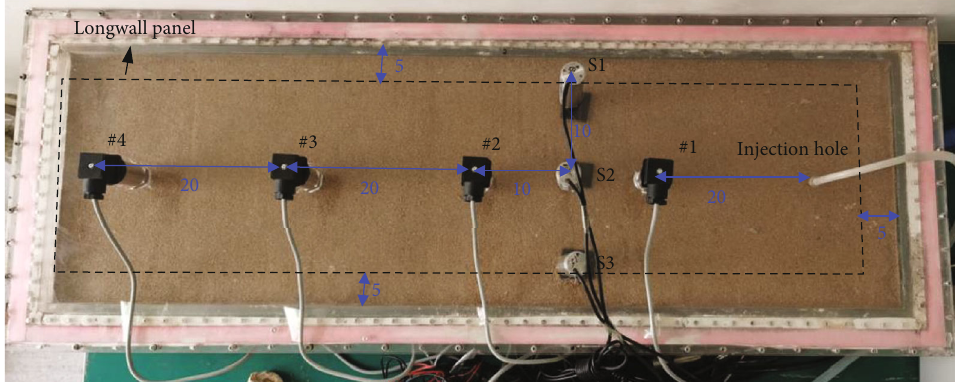
Figure 5: Locations of the sensors, borehole, and longwall panel (unit: cm).